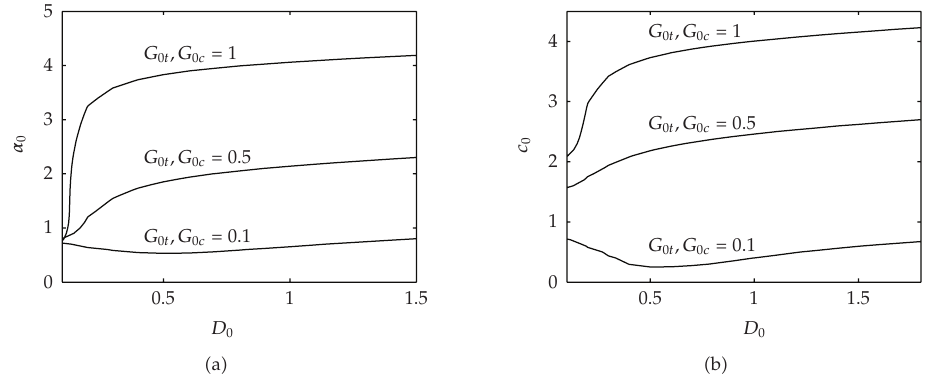
Figure 3: Full eigenrelation prediction of (cid:3) a (cid:4) the linear neutral wave number, and (cid:3) b (cid:4) the linear neutral wave speed (cid:3) — (cid:4) , with (cid:3) G 0 t ,G 0 c (cid:4) (cid:8) 0 . 1 , 0 . 5, and 1.